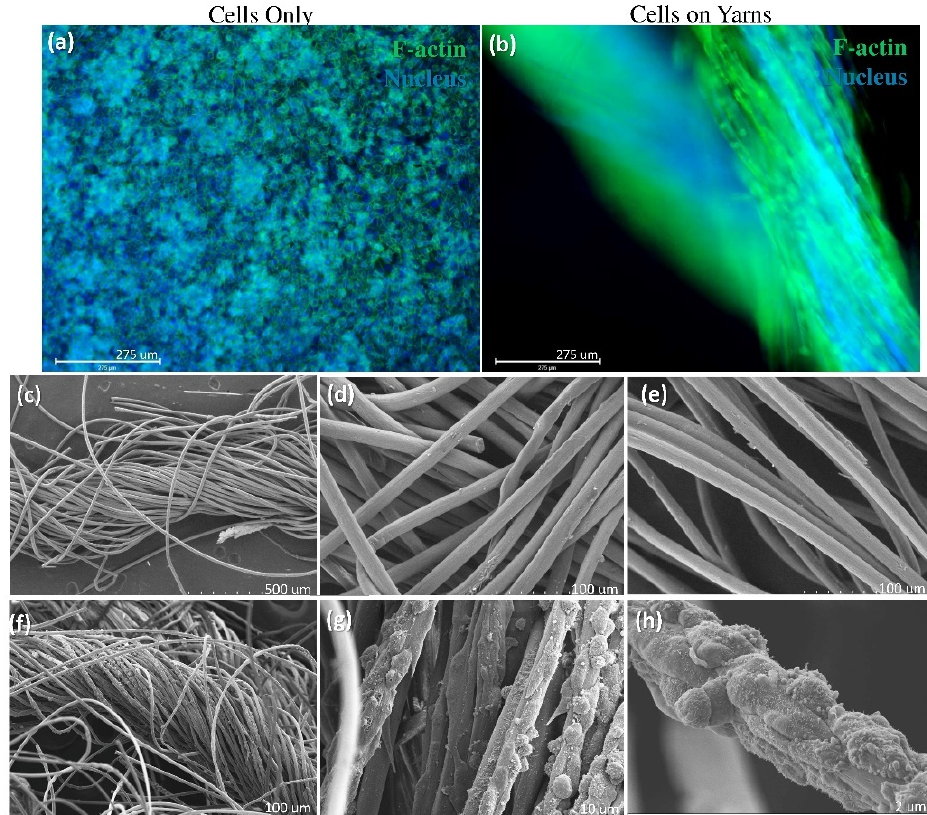
Figure 6. Cells proliferate along the length of the collagen yarns. The samples were stained with phalloidin to identify the cytoskeleton of the cells on the collagen yarns at day 7 ( a , b ). F-actin, a cytoskeleton protein, highlights the typical morphology of the cells ( a ) and highlights the adhesion of the cells along the length of the collagen yarns ( b ), scale bar = 275 µm ( n = 6). Representative SEM images of collagen fibers alone ( c – e ) at varying magnifications. NIH 3T3 cells were seeded and maintained on collagen fiber yarns for 7 days ( f – h ). Scale bar ( a , b ) = 275 µm, ( c ) = 500 µm, ( d – f ) = 100 µm, ( g ) = 10 µm, ( h ) = 2 µm ( n = 3).